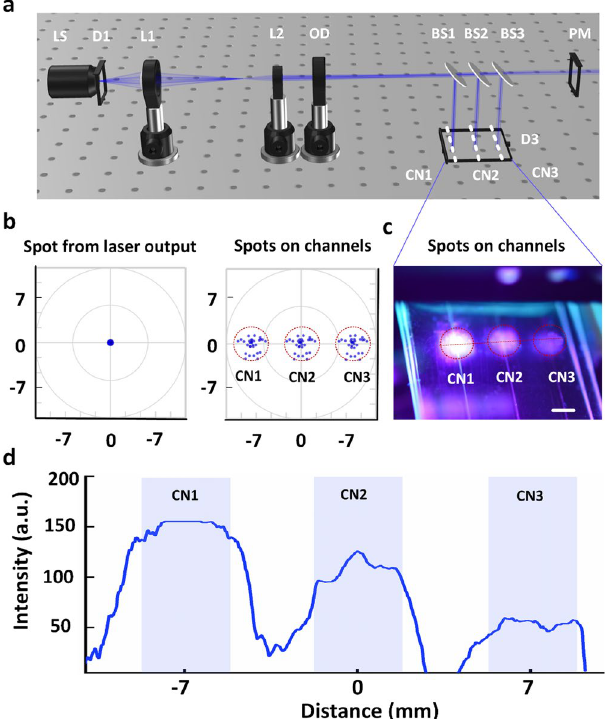
Figure 2. Optical system setup for biofilm treatment: ( a ) optical model setup for simulation, ( b ) simulated beam spots emitted from the laser output (left) and on three observed channels (right), ( c ) measured laser beam spots on the three observed channels in the proposed microfluidic chip, and ( d ) light intensity quantified from the three laser beam spots on the three observed channels ( LS laser source, D1 and D2 optical detectors, L1 and L2 lenses, OD optical diffuser, BS1, BS2, and BS3 beam splitters, PM power meter, CN1, CN2, and CN3 observed channels from 1 to 3 on the microfluidic chip; scale bar = 3